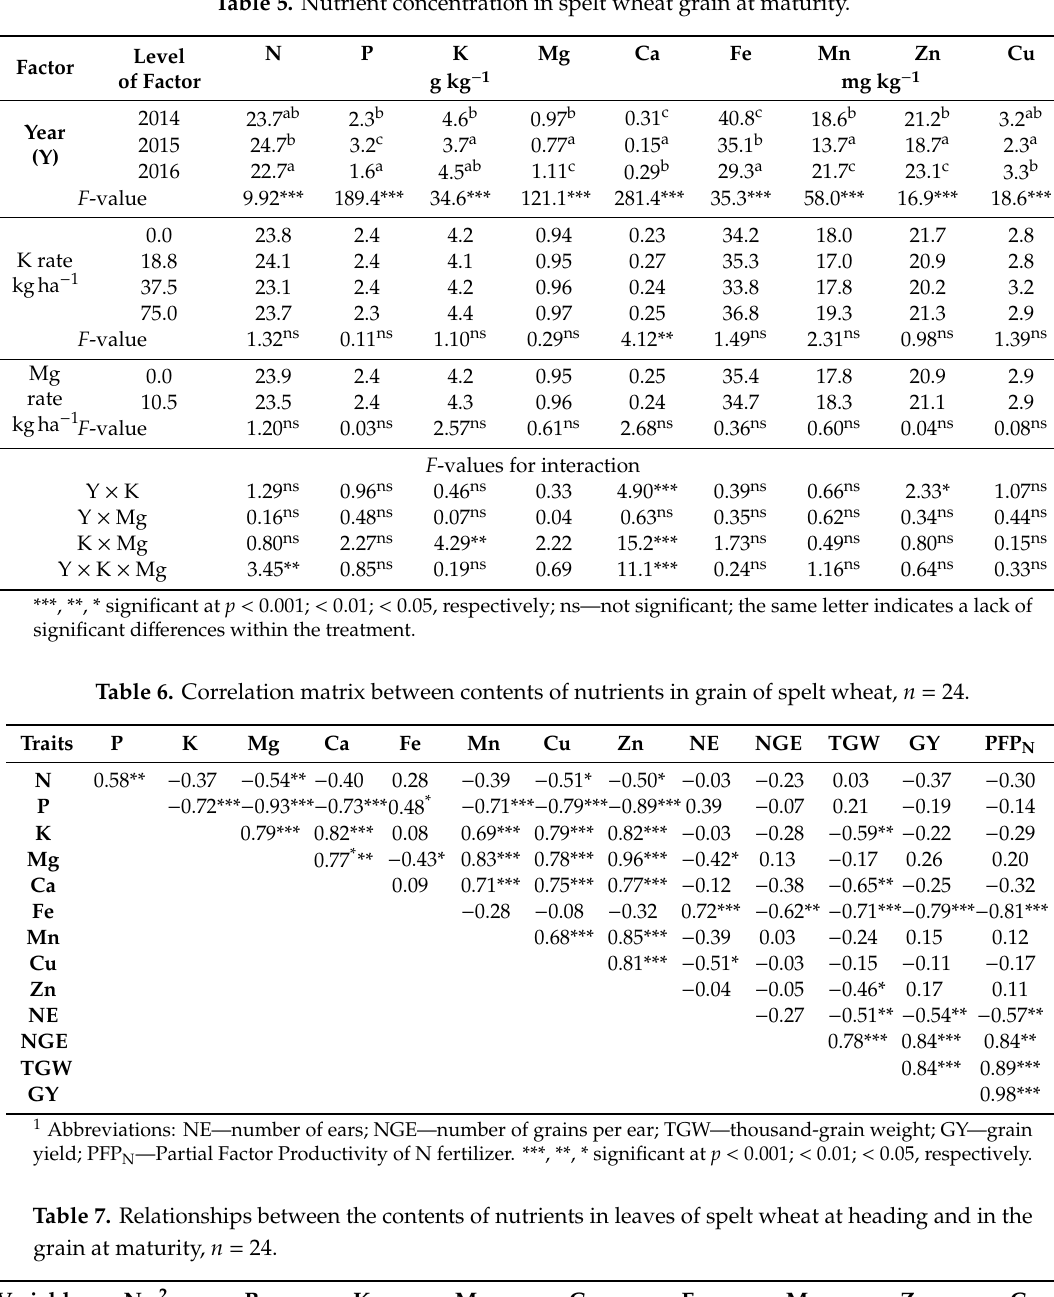
Table 5. Nutrient concentration in spelt wheat grain at maturity.